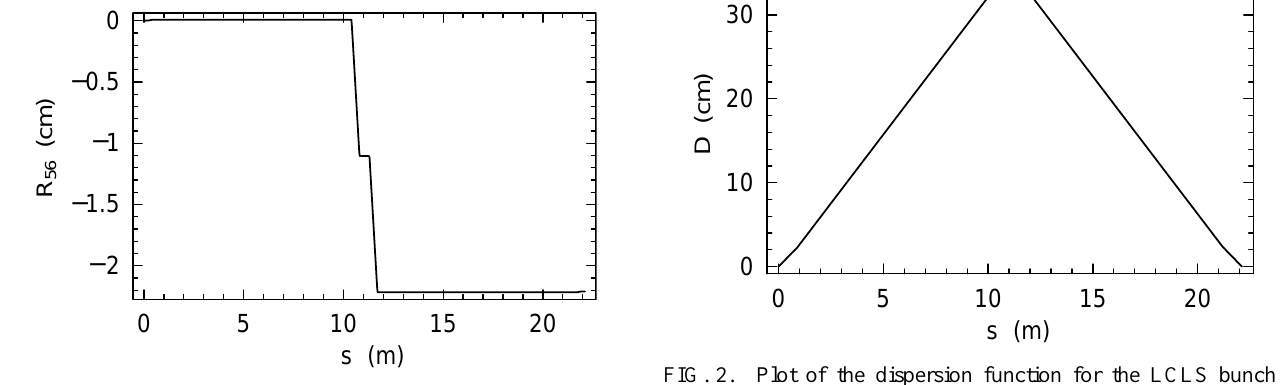
FIG. 1. Plot of R 56 for the LCLS bunch compressor.